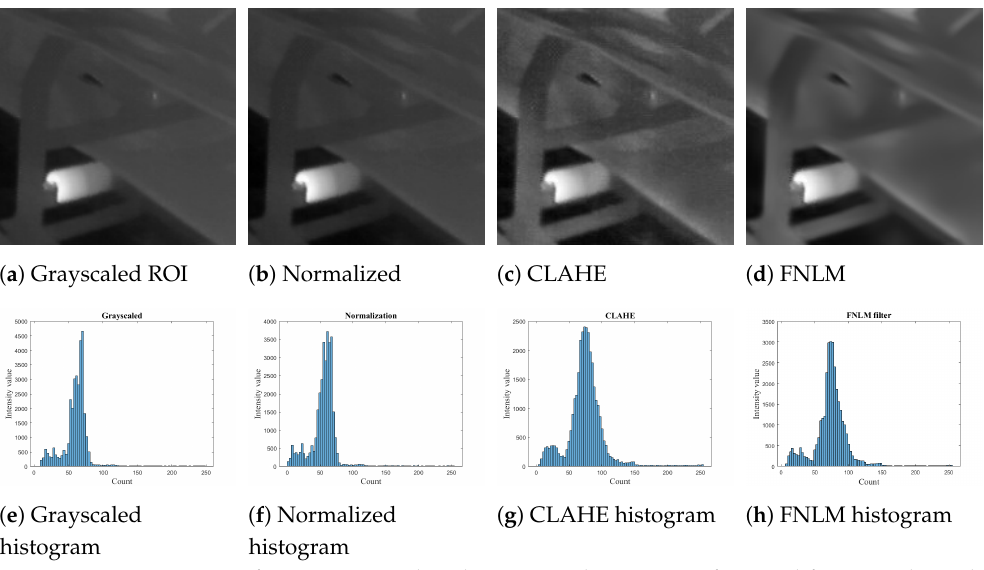
Figure 3. Comparison of a preprocessed and an original IR image after modifications through preprocessing